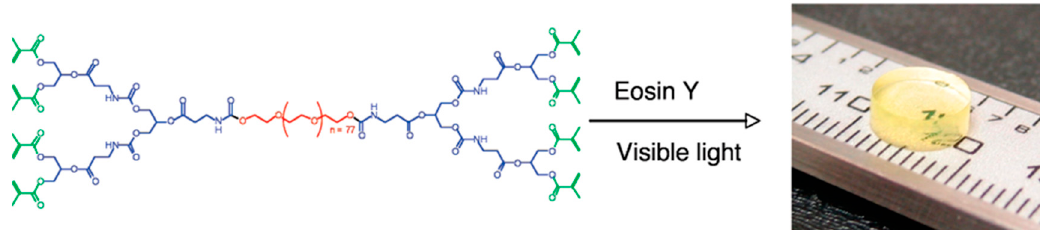
Figure 12. Photo-crosslinkable methacrylated G1 PEG DLD copolymer carbamate conjugate ( left ) and the obtained hydrogel ( right ). Reprinted with permission from [37], Copyright © 2008 American Chemical Society.